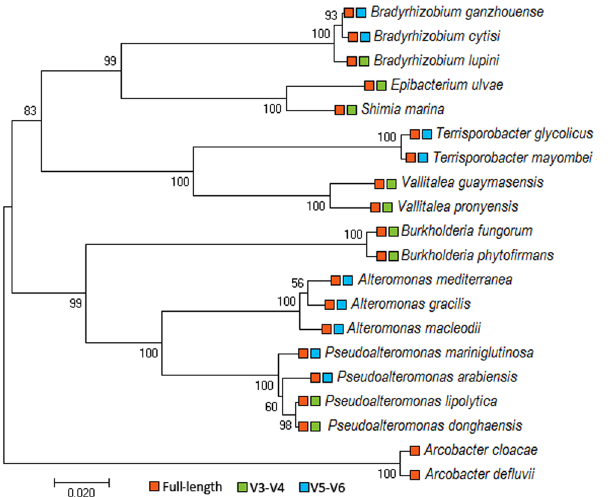
Figure 7. Comparison of species detection between full-length and partial 16S rRNA sequences. A neighbor- joining phylogenetic tree of 20 species identified in coral-associated microbiome generated using MEGA7. Reference type strain sequences were obtained from the RDP database. The clustering of the sequences was tested by a bootstrap approach using 1,000 replications. Orange, green and blue boxes indicate species that are classifiable based on sequence information from full-length, V3-V4 and V5-V6 regions of the 16S rRNA genes,